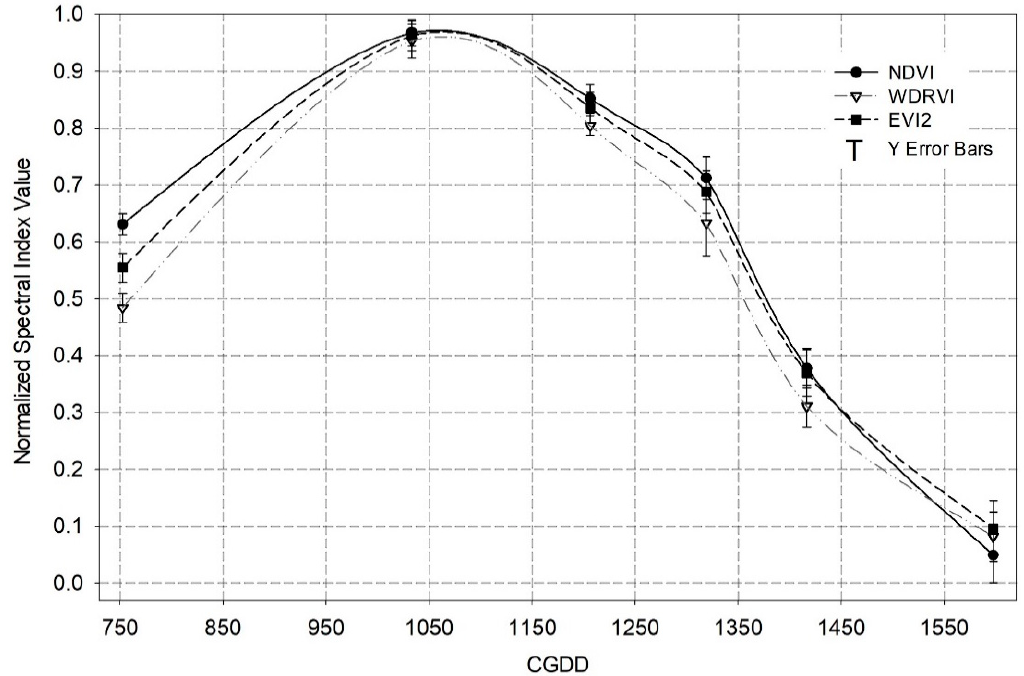
Figure 6. Vegetation spectral indices (VIs)—CGDD relationship with all plots’ values, estimated based on case